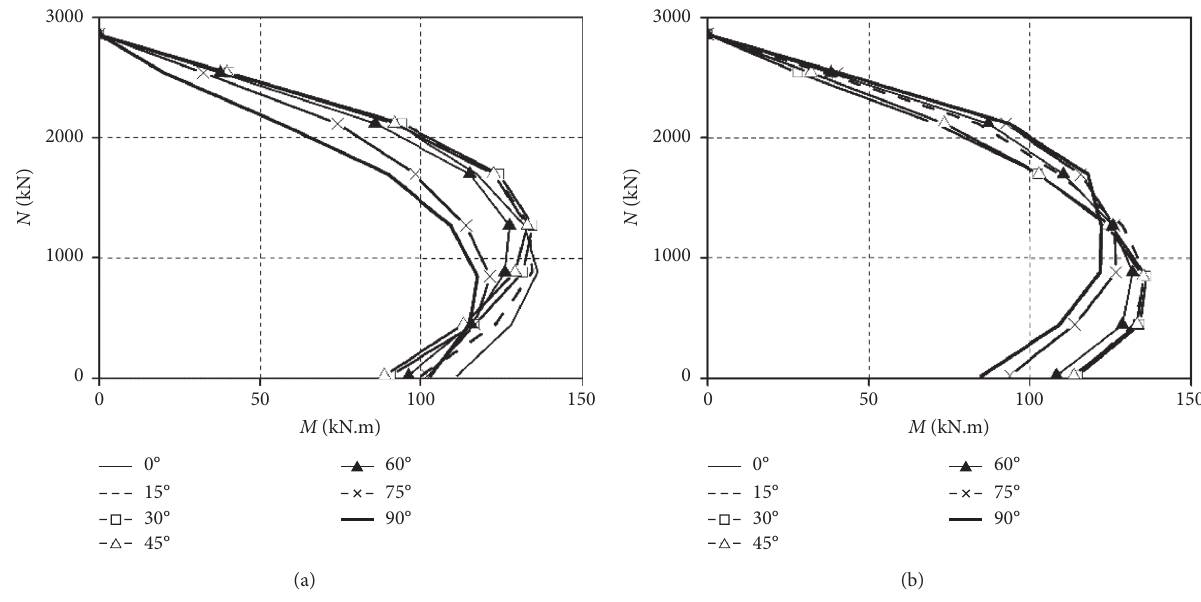
Figure 11: Influence of loading angle θ on the resistance correlation curves. (a) Positive angle loading. (b) Negative angle loading.